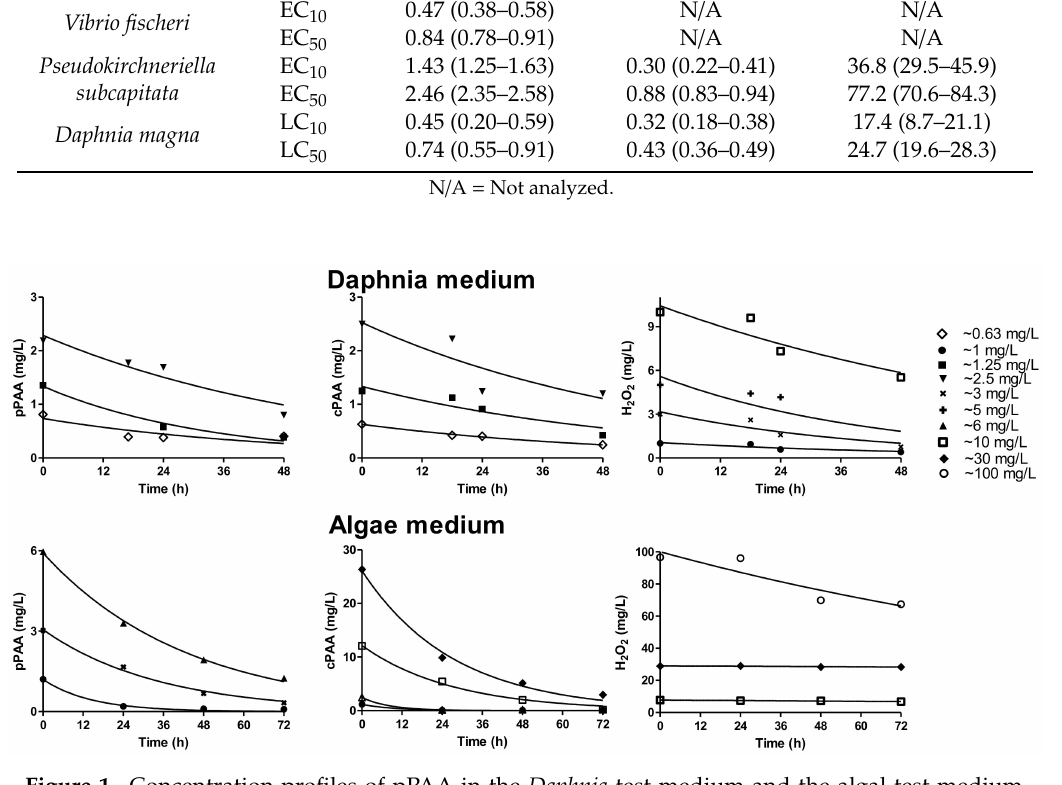
Figure 1. Concentration profiles of pPAA in the Daphnia test medium and the algal test medium. Concentration profiles of commercial PA (cPAA) and hydrogen peroxide in a Daphnia test medium and an algal test medium were derived from Chhetri et al. [26,27]. The fitted curve was based on the first-order degradation kinetics model presented in Equation